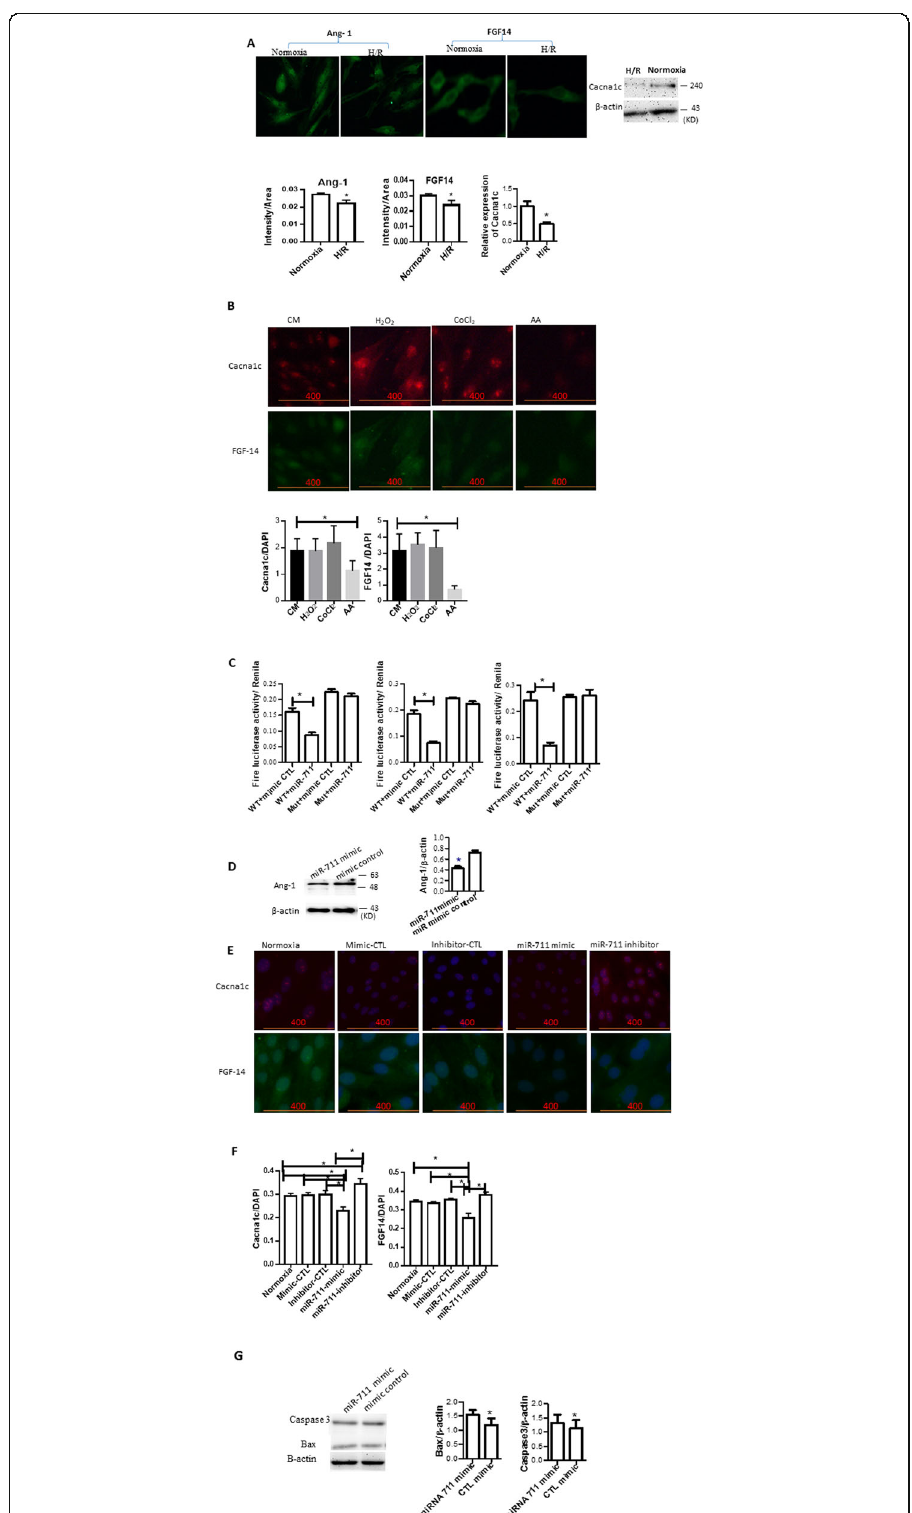
Fig. 4 (See legend on next